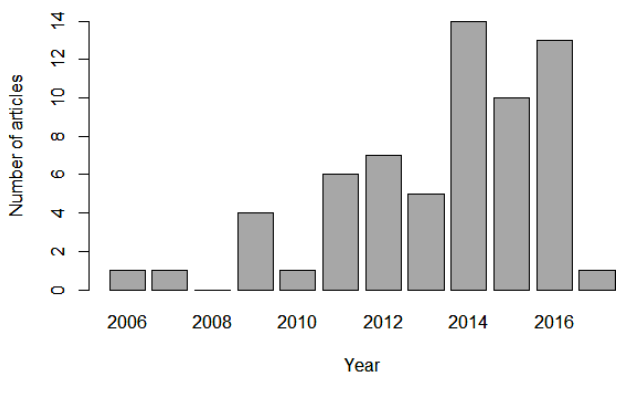
Fig. 1. Number of original research articles that used autonomous recording units for avian research that were published in peer-reviewed journals over time. See Table A1.1 in Appendix 1 for a list of all articles included in this